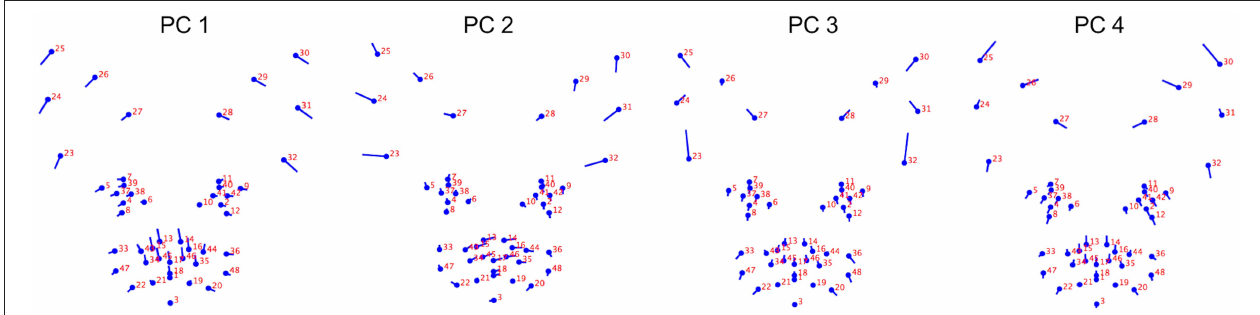
FIGURE 1 | Geometric representation of the face based on average landmarks from 1,888 unique images of cats across the 19 different breeds. Lollipop graphs depict the relative facial shape changes associated with higher PC scores for PCs 1-4. The lines protruding from each landmark indicate direction and magnitude of movement, with higher PC scores reflecting a greater distance along the line from the circular nodes. Images produced using MorphoJ, Version 1.06d (57).